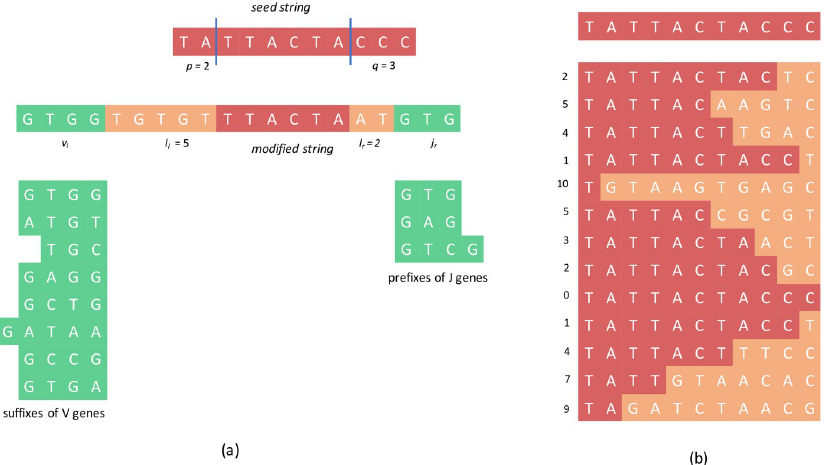
Fig 1. Transformation of a seed string representing a D gene into a modified string representing a CDR3 (a) and a set of modified strings generated according to a simple probabilistic model (b) . (a) The symbols in red, yellow, and green in the modified string denote the symbols from the truncated seed string, random insertions, and V suffixes/ J prefixes, respectively. The sets of V suffixes and J prefixes are shown below the modified string. Note that the sequences shown here are only for illustration and do not correspond to any real genes. (b) In a simple probabilistic model, suffixes of length k are trimmed from the seed string, and the trimmed string is extended by k random symbols, where k (shown by numbers on the left) is chosen uniformly at random. Note that in most cases, there are multiple ways a modified string can be generated from the original string. For example, the first modified string can be generated from the original string by trimming the suffix “CC” and adding the string “TC” or by trimming the suffix “CCC” and adding the string